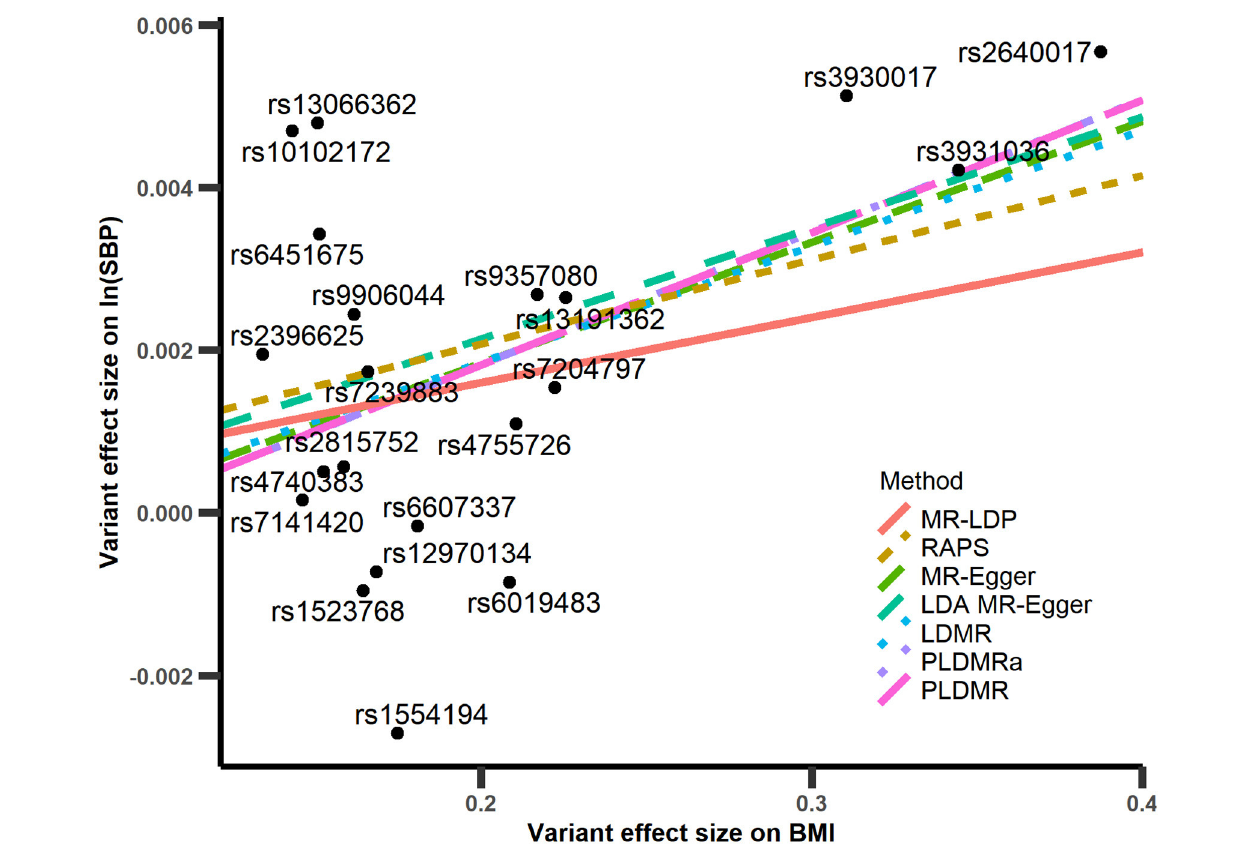
FIGURE 5 | Scatter plot of ˆ Ŵ with respect to ˆ γ in the analyses of BMI-SBP. The red line is the regression line of MR-LDP method, the brown dashed line is the regression line of RAPS, the yellow-green dashed line is the regression line of MR-Egger method, the green dashed line is the regression line of LDA MR-Egger method, the blue short dashed line is the regression line of LDMR method, the purple short dashed line is the regression line of PLDMR a , and the magenta long dashed line is the regression line of